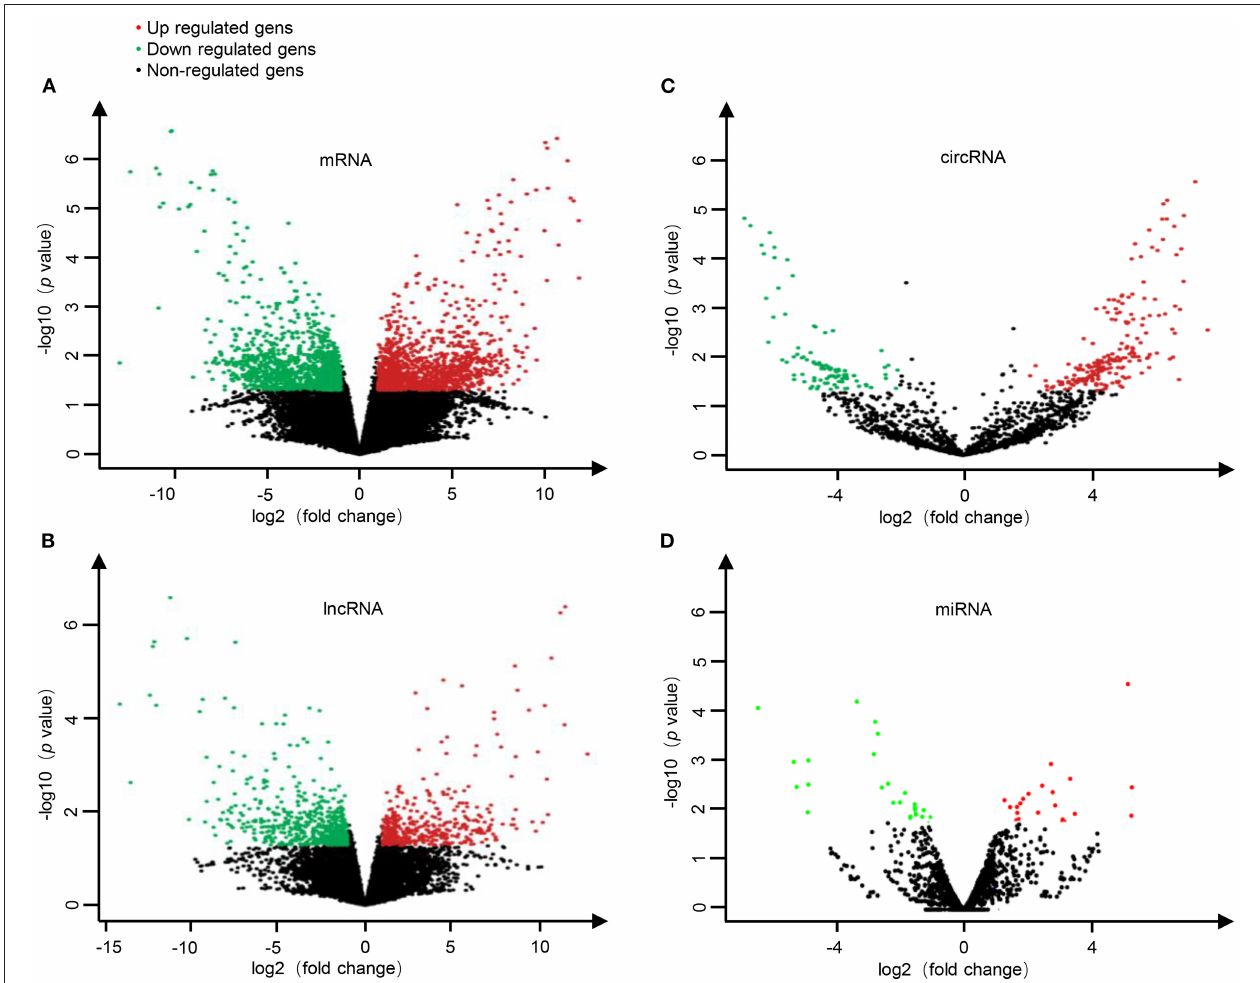
FIGURE 1 | The volcano plots of differential mRNA (A) , lncRNA (B) , circRNA (C) , and miRNA (D) expression between HT group and non-HT group. Red dots represent up-regulated differential genes (fold change ≥ 2 and p -value < 0.05), green dots represent down-regulated differential genes (fold change ≤− 2 and p -value < 0.05), and black dots represent genes with no significant differences.